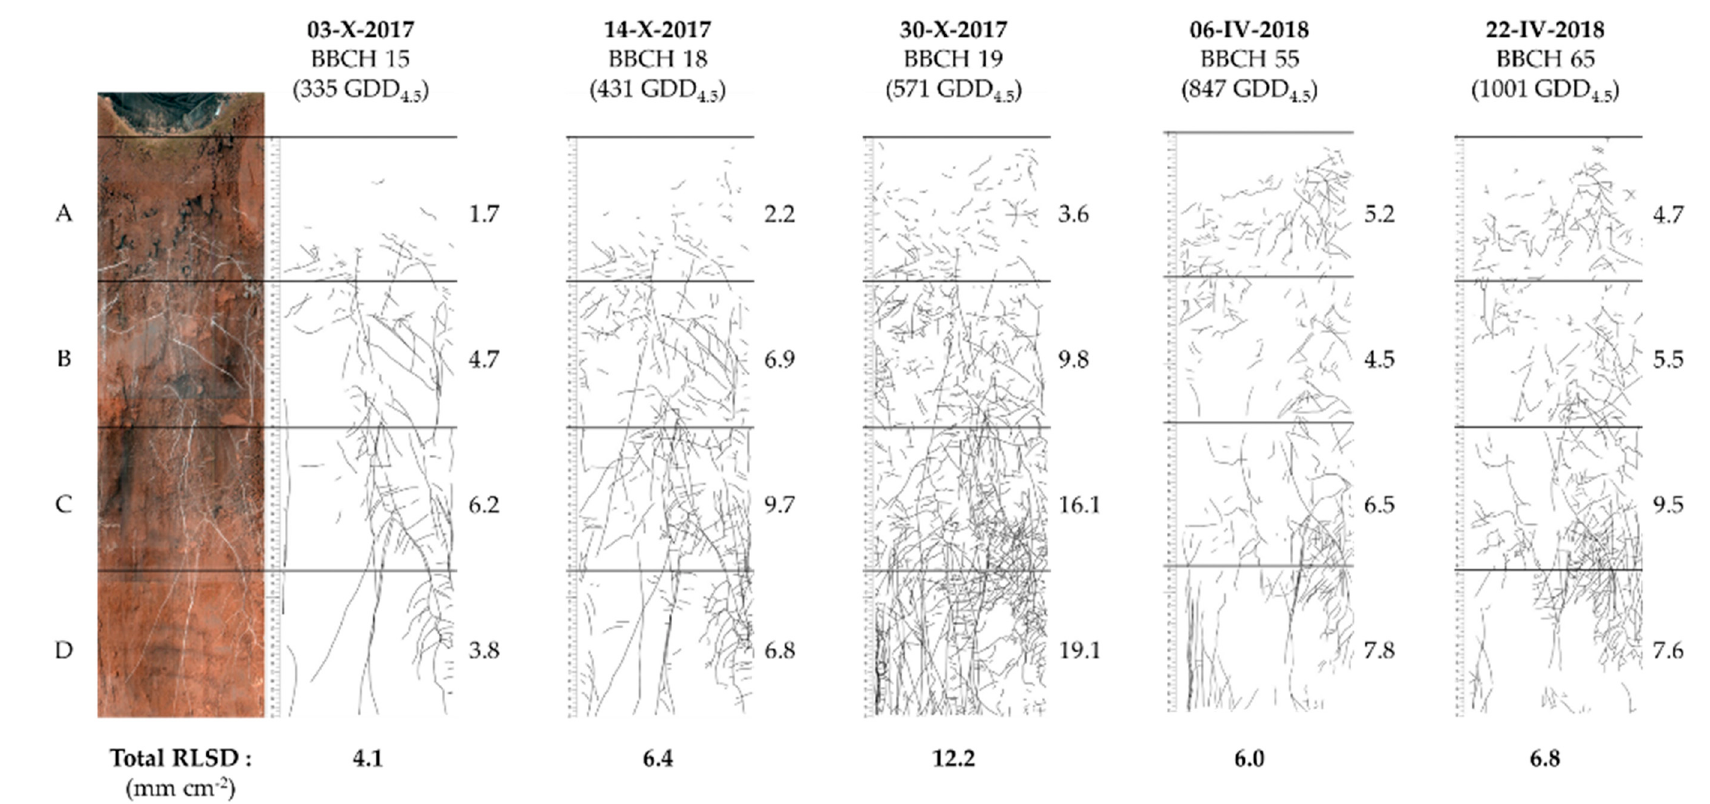
Figure 2. Example of image analysis and quantification of root length surface density. The DK Exception (DKE) cultivar received N+ treatment. Root length surface density (RLSD) values (mm cm − 2 ) are shown in different soil horizons and at different time points of the growing season. The soil horizons are indicated by different letters: A = 0–12 cm; B = 12–24 cm; C = 24–36 cm, and D = 36–48 cm. The BBCH-scale indicates phenological development stages [24,25]. GDD: growing degree days.